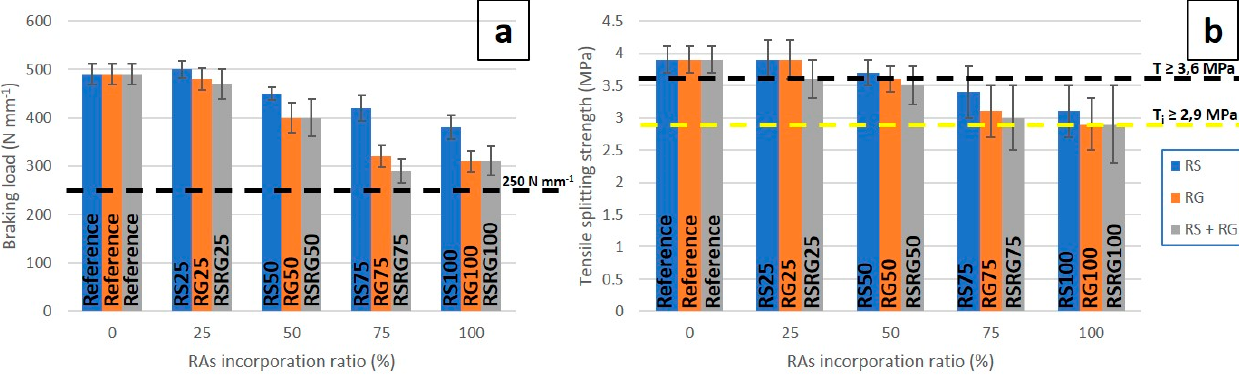
Figure 6. Graphical representation of breaking load ( a ) and tensile splitting strength ( b ) vs. RAs’ incorporation ratio in pavers.